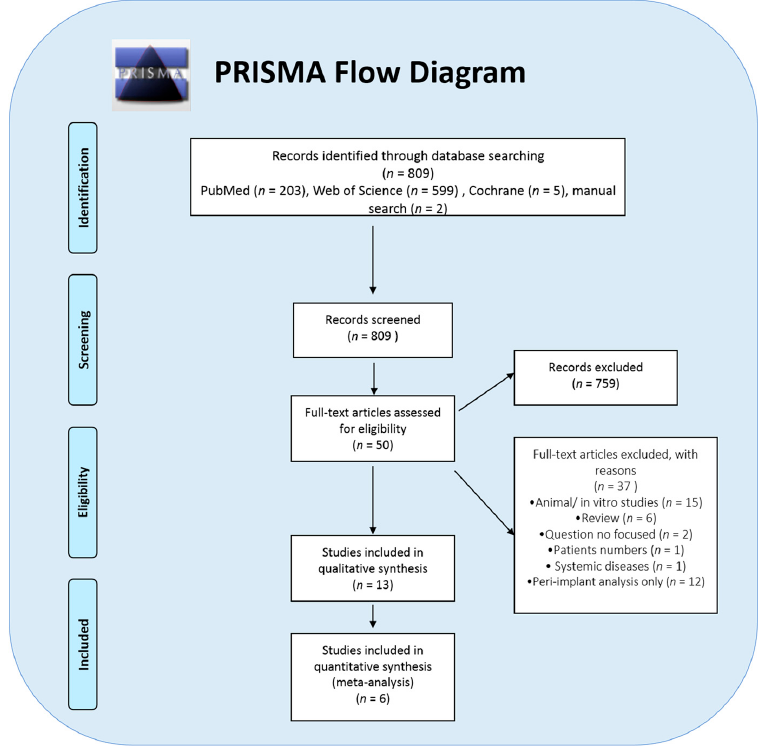
Figure 1. A flowchart representing the literature search, screening, eligibility and selection of this